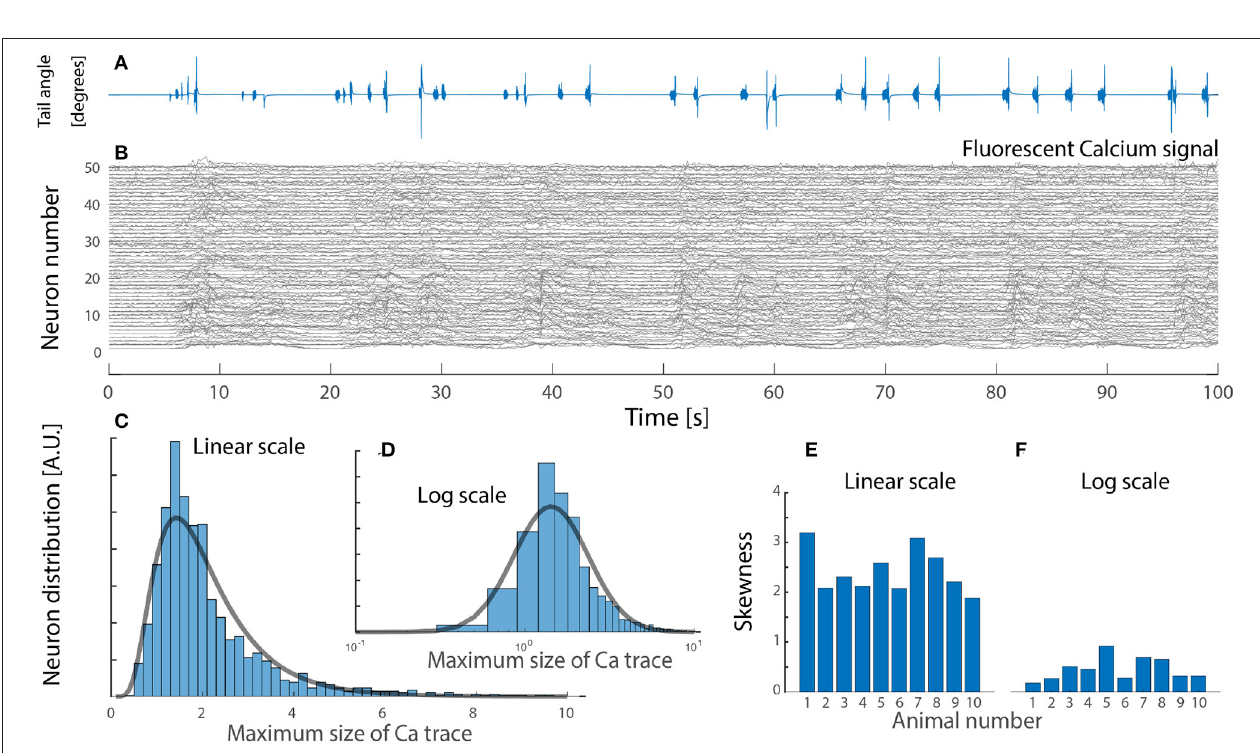
FIGURE 5 | Neuronal imaging of calcium-dependent fluorescent signal in zebrafish larvae hindbrain during visuomotor response has a skewed lognormal-like distribution in peak signal. (A) In-vivo tail-bending in response to visual input. (B) Fluorescent signal ( 1 F / F ) at neuronal resolution of a glycinergic subpopulation which provide inhibitory feedback during escape response (50 cells shown). (C) The maximal calcium response across cells in the population is skewed and lognormal-like (lognormal fit, gray line). (D) Same distribution on log scale resembles a normal distribution (gray fit). (E) High skewness across the cohort ( n = 10 animals). (F) Skewness on a log scale is closer to zero, i.e., normal distribution. Data kindly provided by Severi et al. (2018) and reanalyzed with